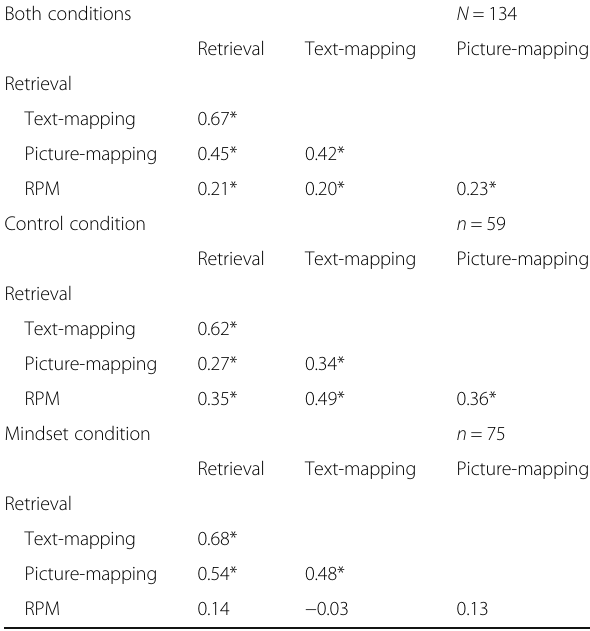
Table 3 Correlations ( r scores) between relational retrieval, ratings of the relational match passage in the text-mapping task, relational choices in the picture-mapping task, and Raven ’ s Progressive Matrices (RPM) scores for experiments 1 and 2 Both